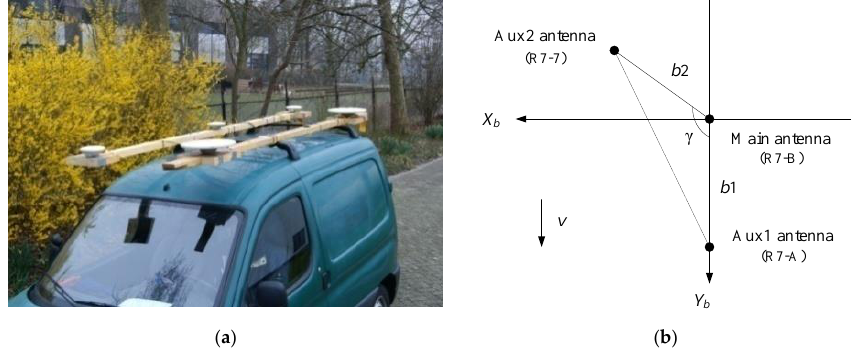
Figure 5. GNSS antennas configuration in kinematic experiment: ( a ) the antenna configuration; and ( b ) the antenna geometry indication.